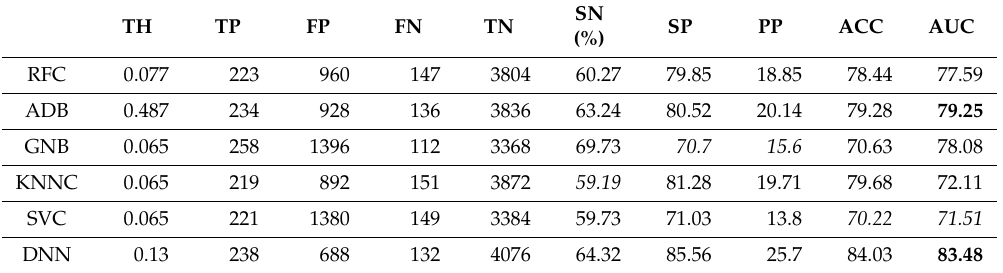
Table 3. Comparison of the confusion matrix values and performance for six classifiers (testing